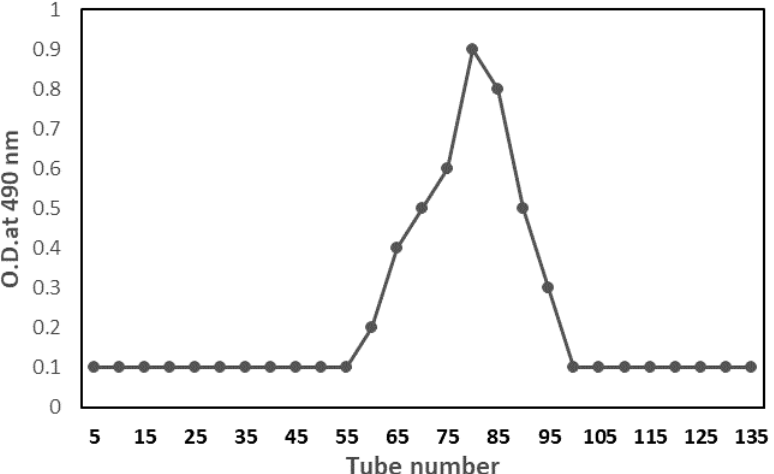
Figure 4. Gel permeation chromatography of polysaccharide fraction on Sephacryl S-200.